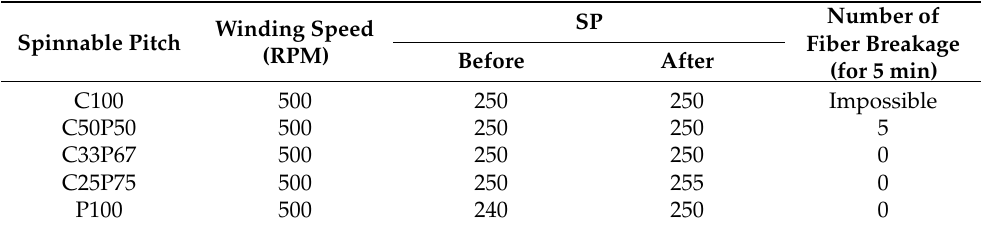
Table 4. Spinning results of spinnable pitch prepared by co-carbonization of purified coal tar pitch and PFO in various